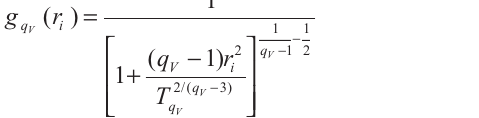
algorithm. Using a stop criteria of 2,500,000 steps, the pa- rameters were scanned using a 0.1 step in the intervals 1.1 ≤ = . The entire process was repeated 50 times for every parameter set with different random ini- tial conditions for each